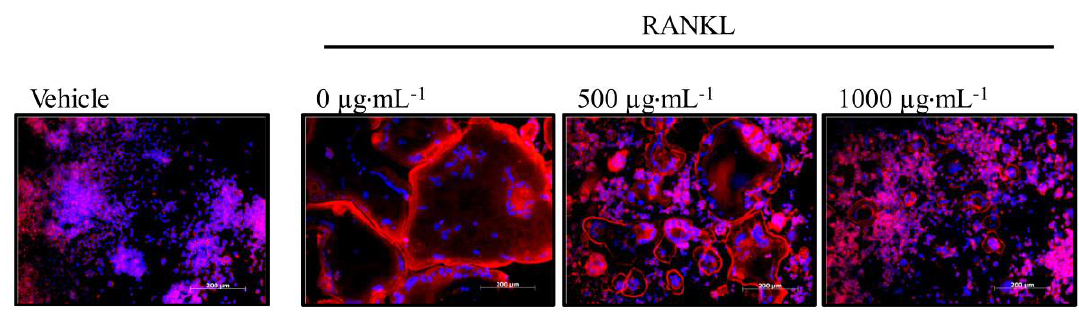
Figure 3. Effect of honeybush tea extract on bone resorption. Cells were seeded onto osteoassay plates and exposed to RANKL (30 ng  mL −1 ) alone or in combination with honeybush tea extract at increasing concentrations for 5 days. ( A ) Photomicrographs of resorption pit formation in 24-well osteoassay plates. Light areas are the resorbed surfaces. Scale bar = 1000 µm. ( B ) Resorption pit formation was quantified using Image J software. Data are mean ±SD and are representative of three independent experiments conducted in triplicate. * p < 0.05; ** p < 0.01; *** p < 0.001 vs. control.